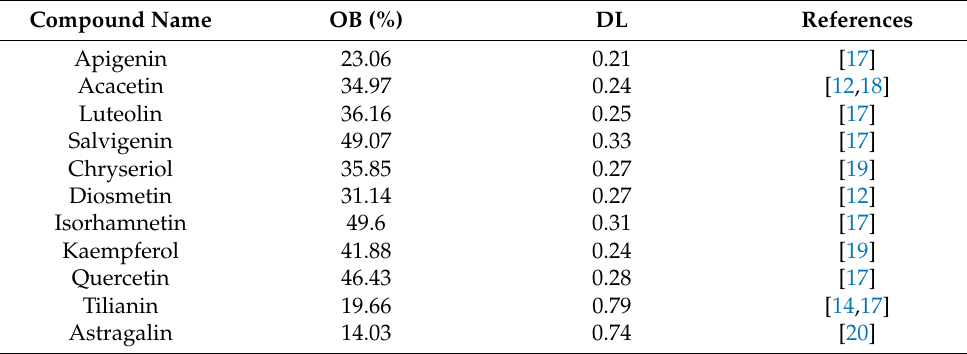
Table 1. The eleven flavonoids obtained from